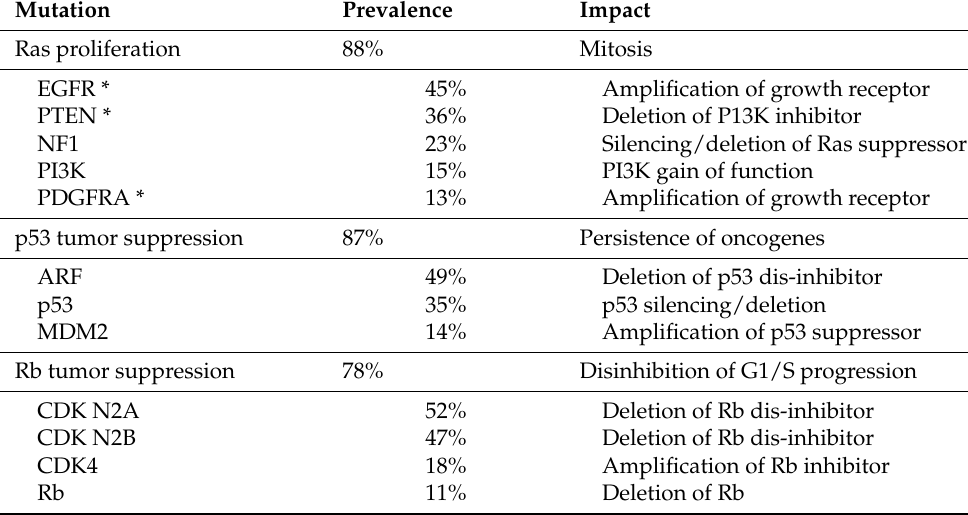
Table 1. Prevalence of oncogenic mutations and expression abnormalities in glioblastoma biopsy samples in the Cancer Genome